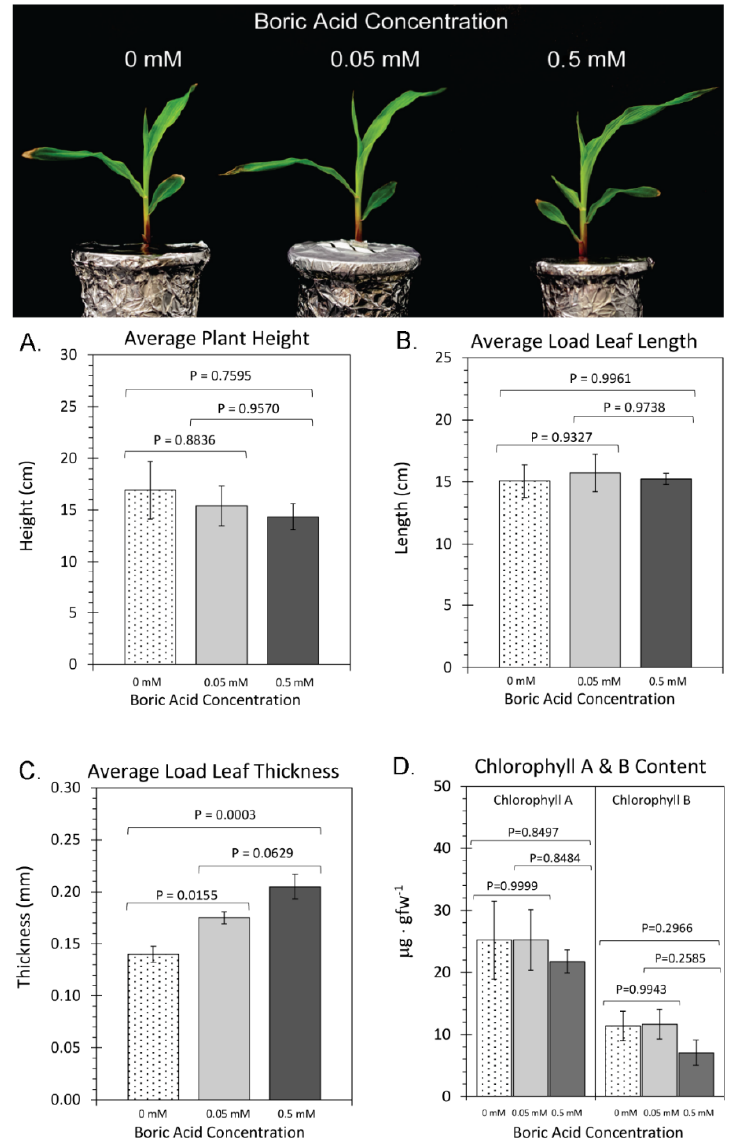
Figure 2. Shoot growth traits: upper panel depicts photos of plants that were grown under three regimes of boric acid (BA) treatment, including: 0 mM BA, 0.05 mM BA, and 0.5 mM BA. ( A ) depicts data on plant height measured in centimeters from the base of stem to the tallest leaf tip. ( B ) depicts data on the load leaf length (leaf two, at developmental stage V2, used to administer 11 CO 2 ) measured in centimeters. ( C ) depicts data on load leaf thickness measured in millimeters. ( D ) depicts data on load leaf chlorophyll A&B content measured in micrograms of chlorophyll per gram fresh weight of leaf tissue ( µ g · gfw − 1 ). All data bars represent average values ± SE from N = 8–10 replicates. Data was subjected to one-way analysis of variance with a post hoc Tukey’s HSD test to account for multiple comparisons between the different treatment groups (0 mM-to-0.05 mM BA; 0.5 mM-to-0.05 mM BA; and 0 mM-to-0.5 mM BA). Statistical significance was set at p <